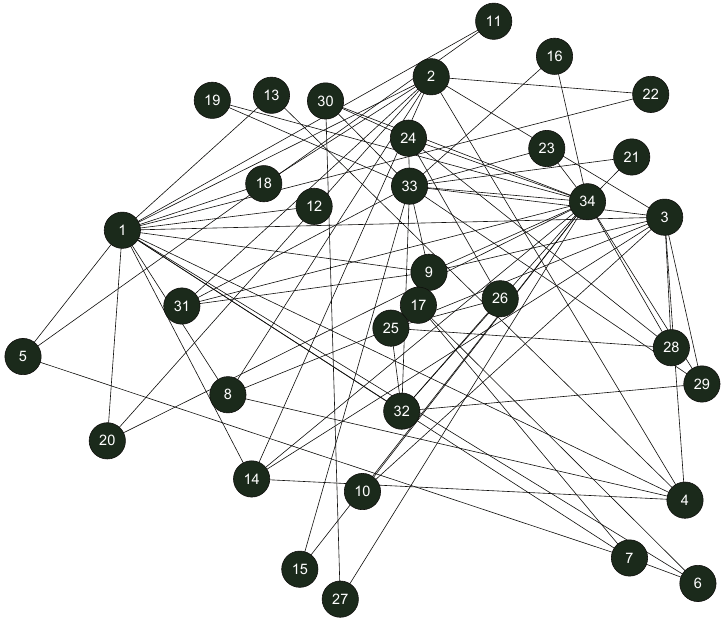
Figure 1. The Karate network.